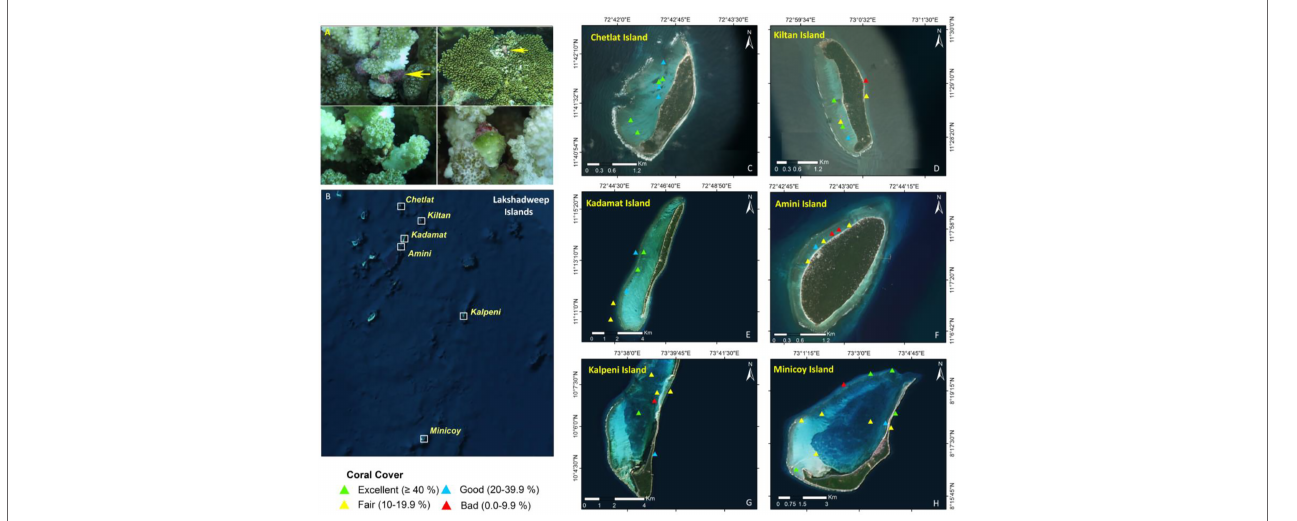
FIGURE 1 | Map showing the study sites. (A) Drupella cornus on the coral; (B) Lakshadweep Archipelago; (C–H) Islands of Lakshadweep